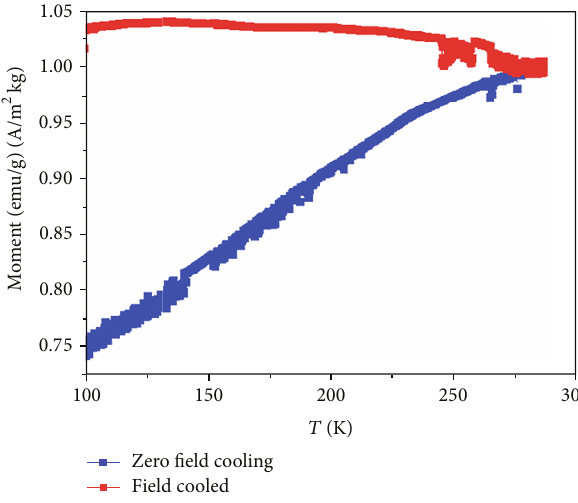
Figure 6: Correlation of predicted and measured dielectric constant based on the theoretical mixing models of Maxwell and Lichte- necker.